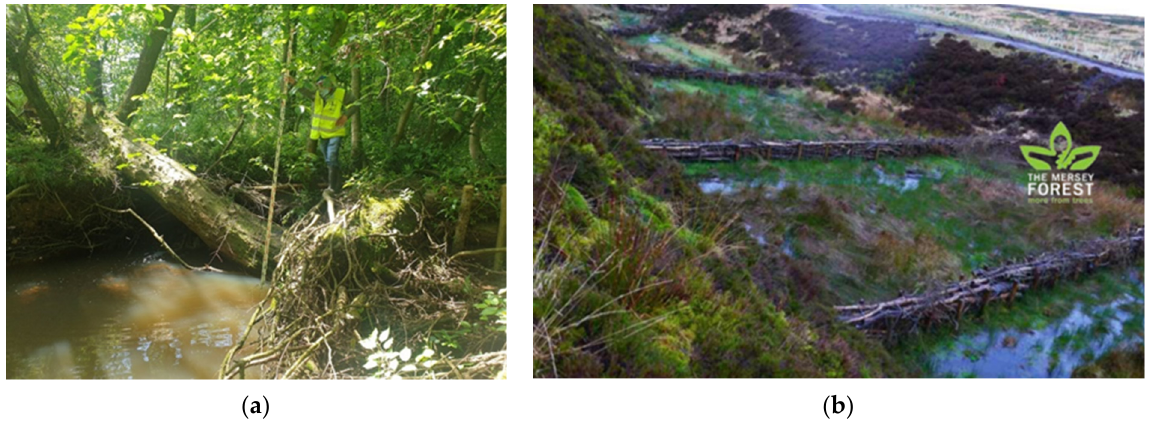
Figure 2. Large woody/engineered log barriers: ( a ) Tees Rivers Trust in Coatham Beck, Co. Durham, in collaboration with EA, Forestry Commission, Stockton Borough Council, Arup and Newcastle University; ( b ) Smithhills, Mersey Forest, Liverpool University and EA [46] (photo by Norbury).